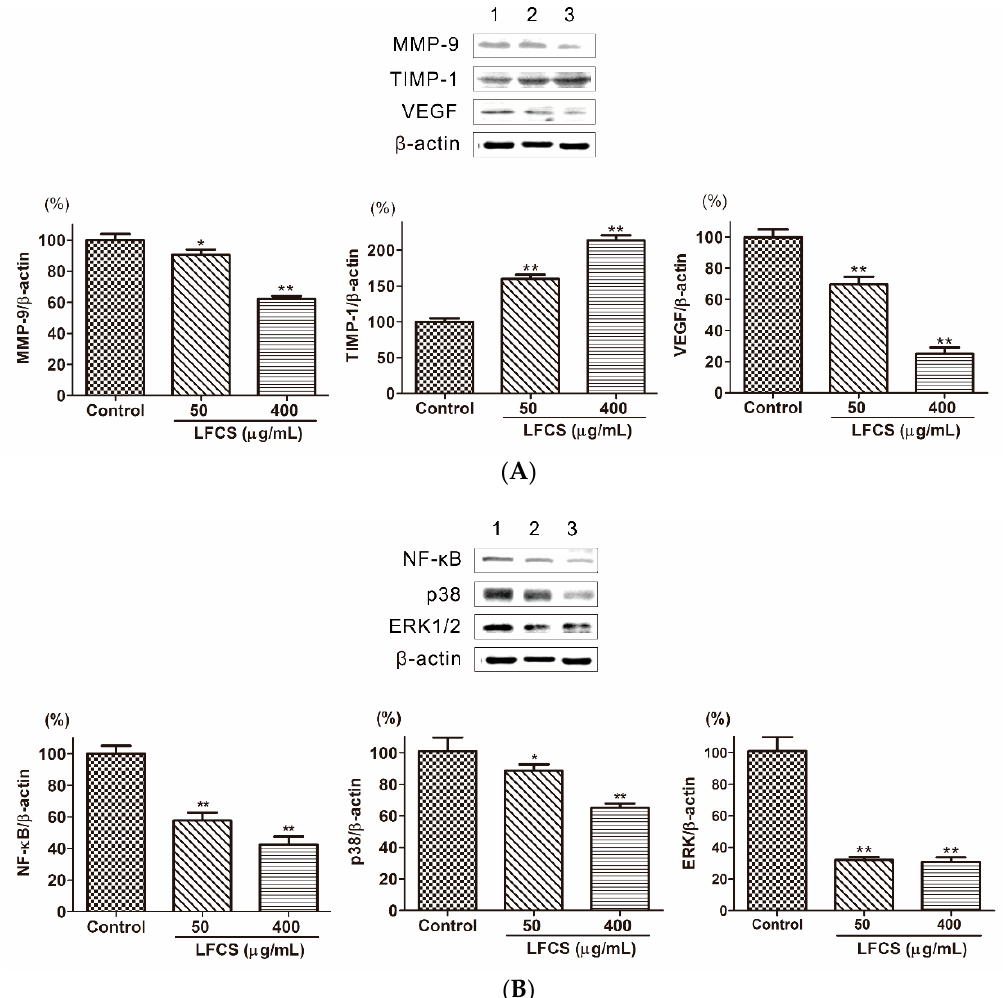
Figure 6. LFCS suppressed metastasis and angiogenesis by regulating protein expression of MMP-9, TIMP-1, VEGF, p38, ERK1/2, and NF- κ B in LLC cells after 72 h treatment of LFCS detected by Western blot. ( A ) LFCS increased TIMP-1, and decreased MMP-9 and VEGF expression; ( B ) LFCS suppressed NF- κ B, p38 and ERK1/2 expression. Expression of the β -actin was used as internal control. Lane 1: vehicle-treated cells; Lane 2: 50 μ g/mL LFCS-treated cells; Lane 3: 400 μ g/mL LFCS-treated cells. Data were presented as mean ± SD and derived from one representative experiment performed in triplicate. * p < 0.05, ** p < 0.01, significant difference compared with control group.